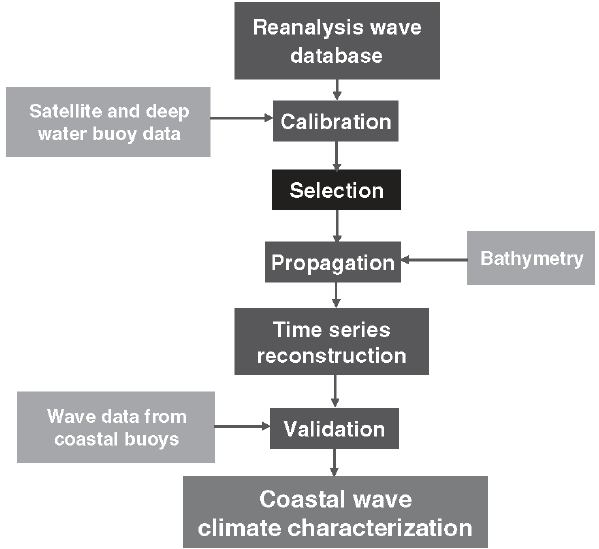
Figure 4. Methodology to downscale wave climate to coastal